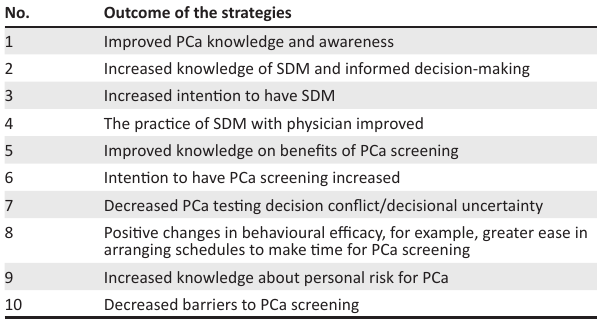
TABLE 2: Strategies engaged to enhance prostate cancer awareness and practice. ‘HOW’ health ‘WHAT’ health education education